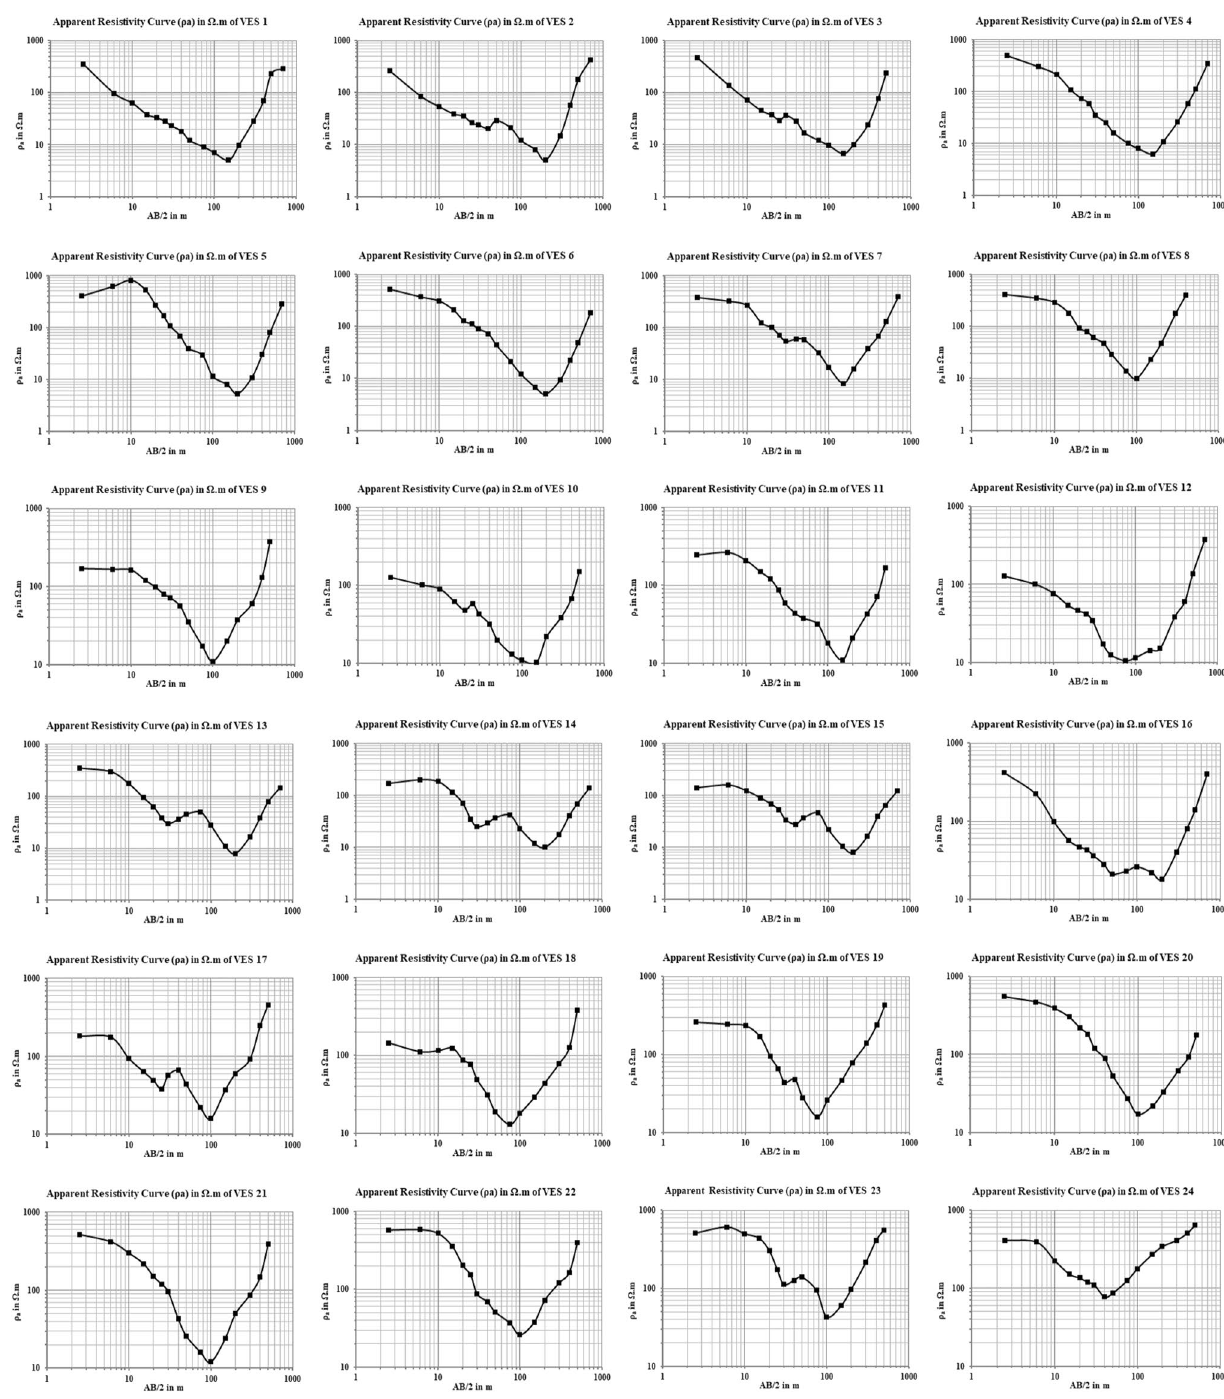
Fig. 3 Apparent resistivity curves of the measured VESs